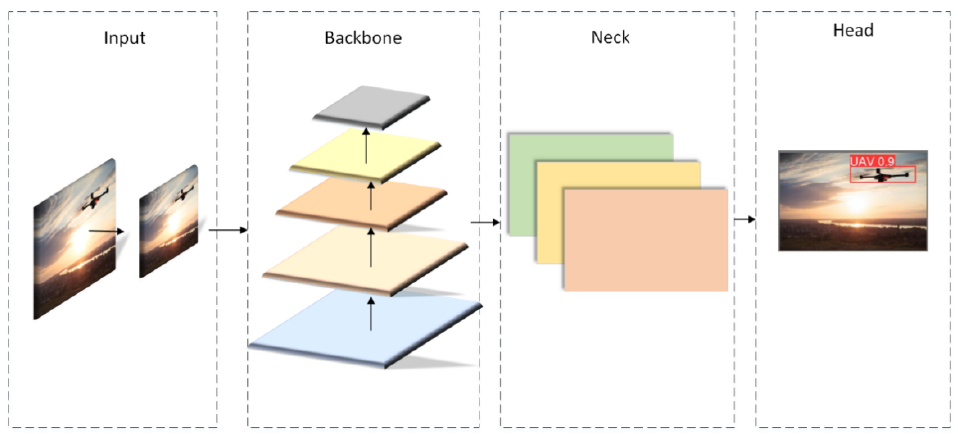
Figure 1. The framework of